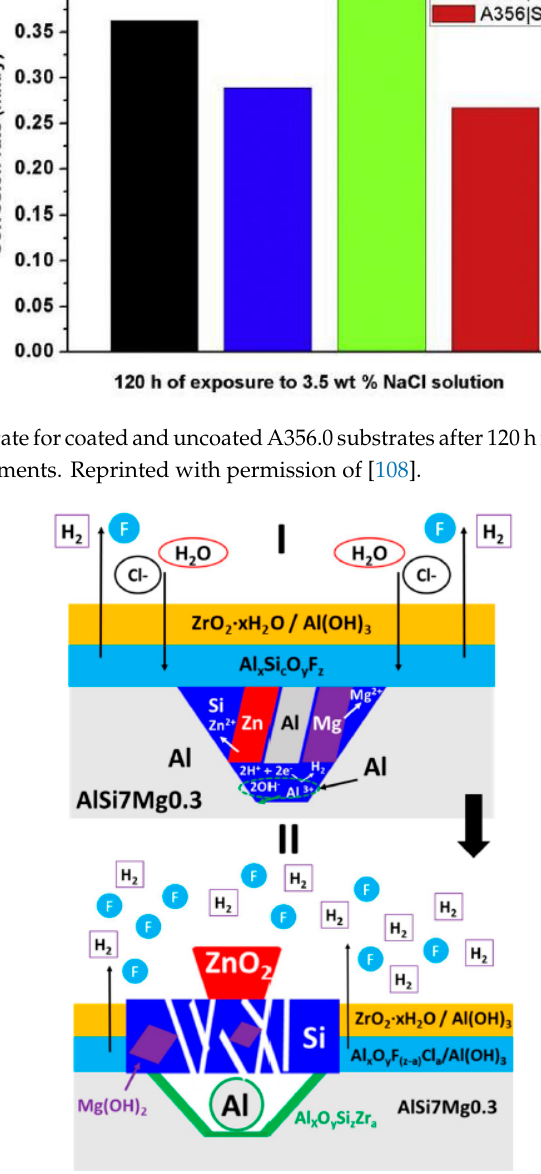
Figure 20. Schematic presentation of the self-sealing mechanism of zirconium conversion coating Figure 6. Weight loss rate curves of ADC12-xYb aluminum alloys immersed in 3.5 wt % NaCl solution applied on AlSi7Mg0.3 during its immersion in 0.5 M NaCl solution. Reprinted with permission of for 10, 20, 30 days. Reprinted with permission from Elsevier [11].